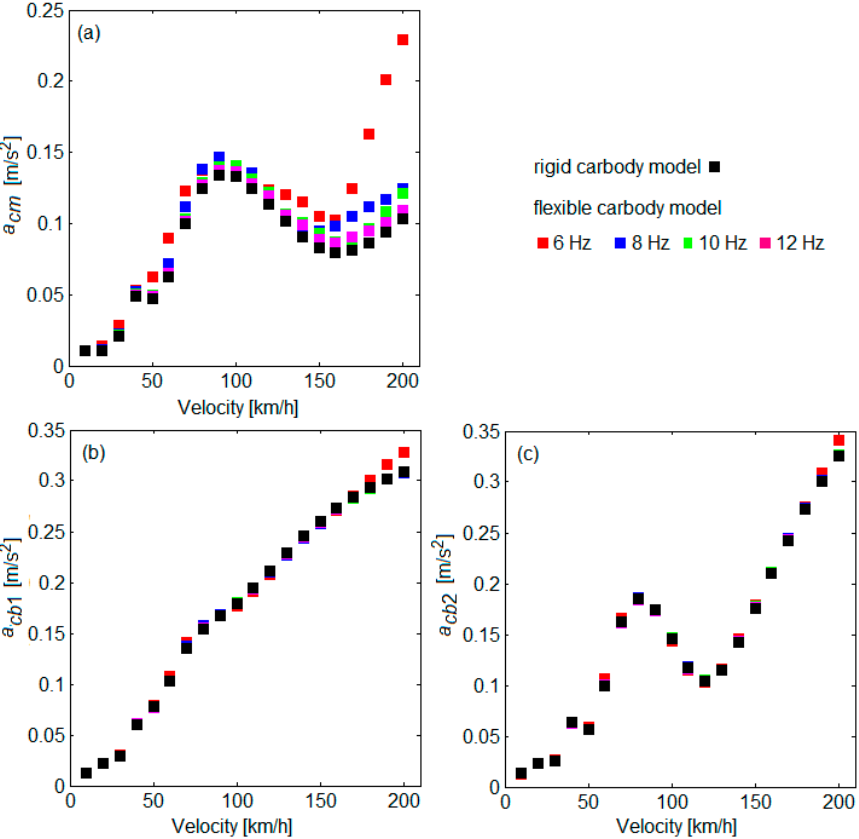
Figure 4. Influence of the carbody vertical bending upon the root mean square of acceleration in correlation with the velocity: ( a ) at the carbody centre; ( b ) against the front bogie; ( c ) against the rear bogie.